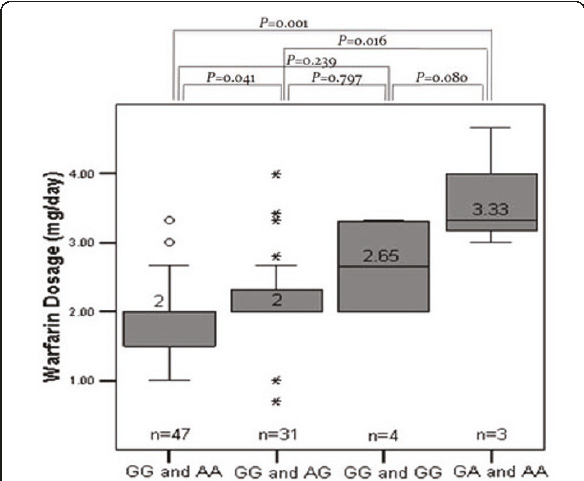
Figure 1 Box plot of the distribution for warfarin dose by CYP2C9 rs17847036 (GG and GA) of CYP2C9 and VKORC1 rs9923231 (GG, AG and AA) genotypes . Number indicates the median warfarin dose. P -values for the distributions in each genotype are indicated.